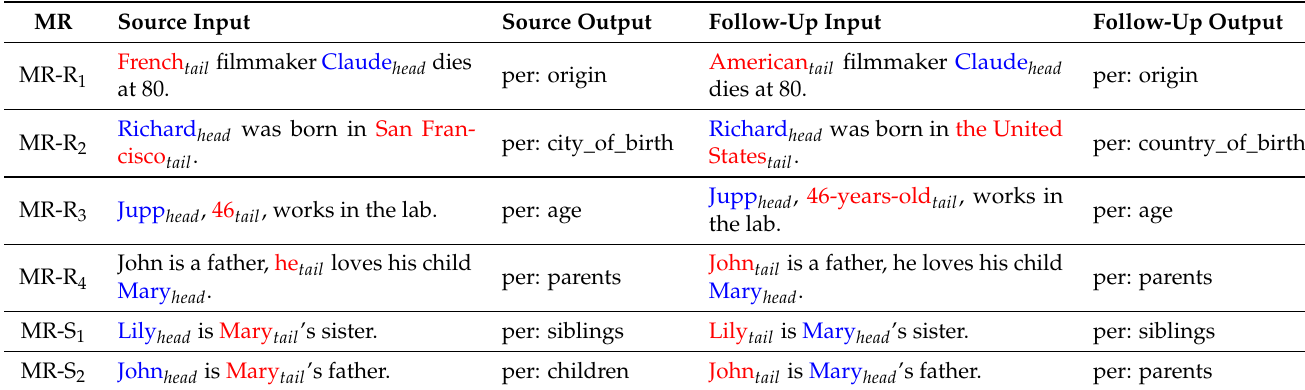
Table 2. Sample MGs of MRs with replacement and swap